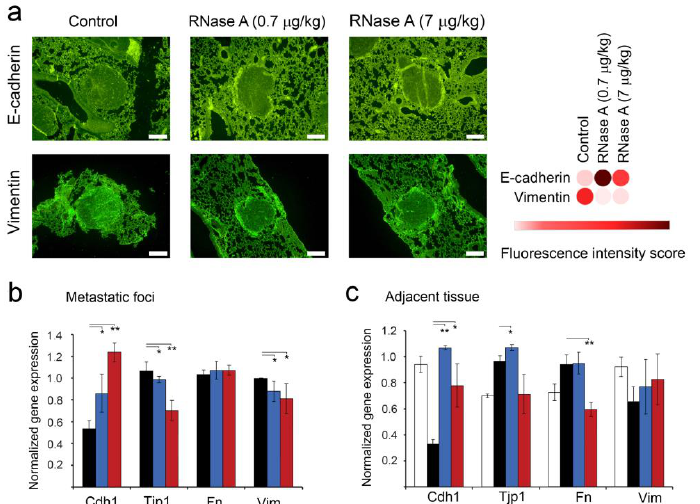
Figure 6. The effect of RNase A on the expression of EMT-associated markers in metastatic foci and adjacent lung tissue of mice with melanoma B16. ( a ) Representative images of fluorescence-based immunohistochemical staining of lung metastases with primary antibodies against E-cadherin and vimentin followed by incubation with secondary antibodies conjugated to Alexa Fluor ® 488 (magnification × 200). Green fluorescence intensities corresponding to expression of E-cadherin and vimentin were calculated for each image using ImageJ software and visualized as a heat map using the Morpheus instrument. ( b , c ) The levels of expression of EMT-associated genes in metastatic foci and adjacent lung tissue, respectively. Data of RT-qPCR. Gene expression levels were normalized to HPRT. Data are presented as mean ± S.E.M. Data were statistically processed using Student’s t -test; * p < 0.05, ** p <